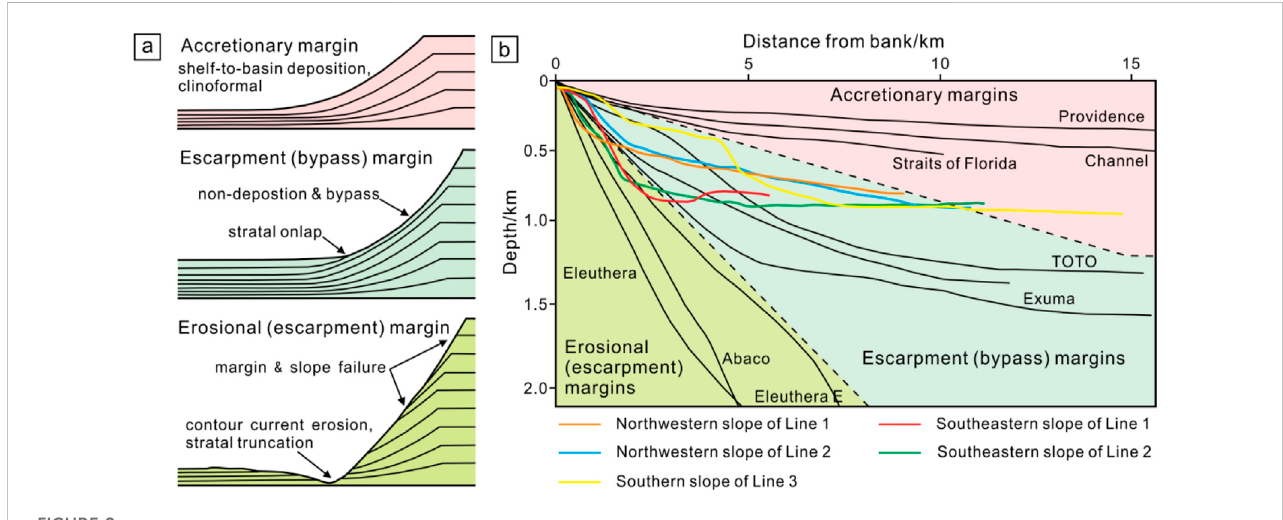
FIGURE 8 (A) Models of accretionary, escarpment, and erosional margins of carbonate platforms, highlighting variations in stratal architecture (modi fi ed from Schlager and Ginsburg, 1981; Playton et al., 2010). (B) Accretionary, escarpment, and erosional depositional pro fi les showing variations in slope angle and slope height. The colorful lines represent the slopes of Yongle Atoll based on the seismic pro fi les in this study. The black lines were Bahamas and Caribbean carbonate margins modi fi ed from Playton et al. (2010). They mainly fall into the domains of escarpment (bypass) margins and erosional (escarpment)